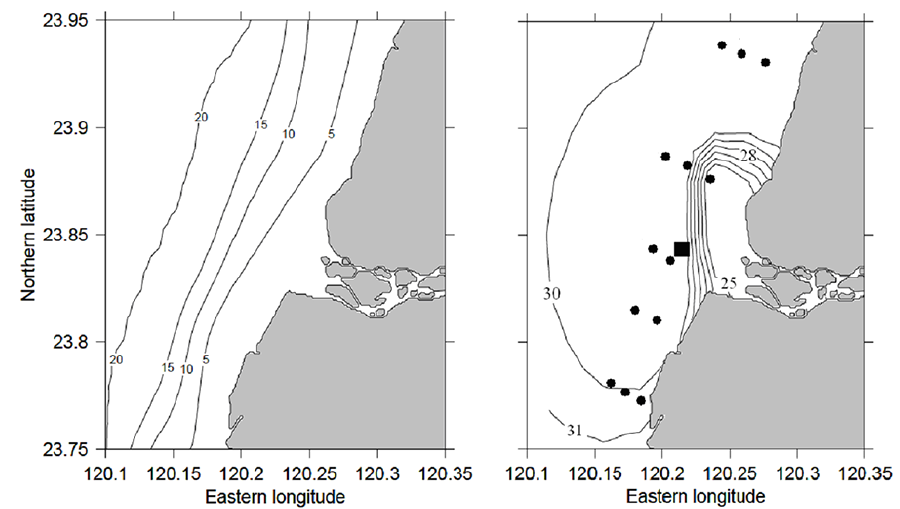
Figure 2. Left: bathymetry of the Zhuoshui mouth area (based on ETOPO1). The isobaths are labelled in metres. Right: map of stations occupied during the field survey in June 2013 (bullets). The black box indicates the position of mooring station with current meter near the bottom. Black curves are the estimated surface salinity contours (morning of 27 June).